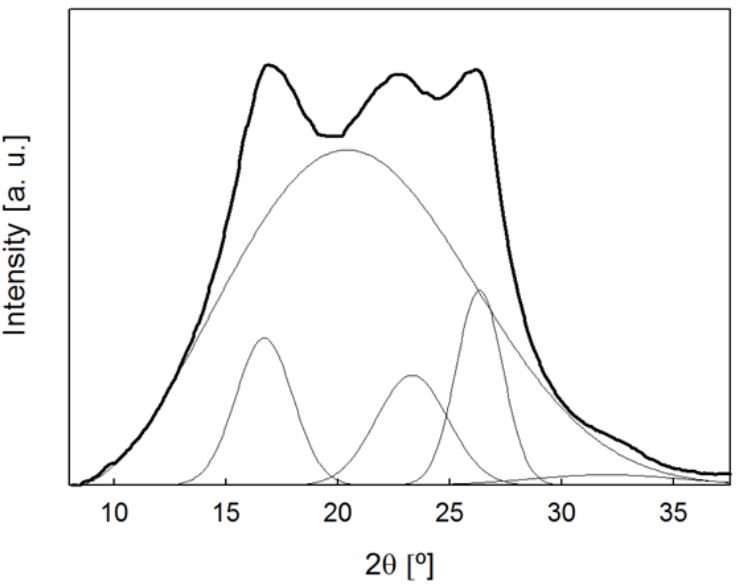
Figure 2. Intensity profile as a function of diffraction angle for a PET/graphene 5 wt.% fiber with 575 μ m radius. The curve is separated into an amorphous halo and several crystalline